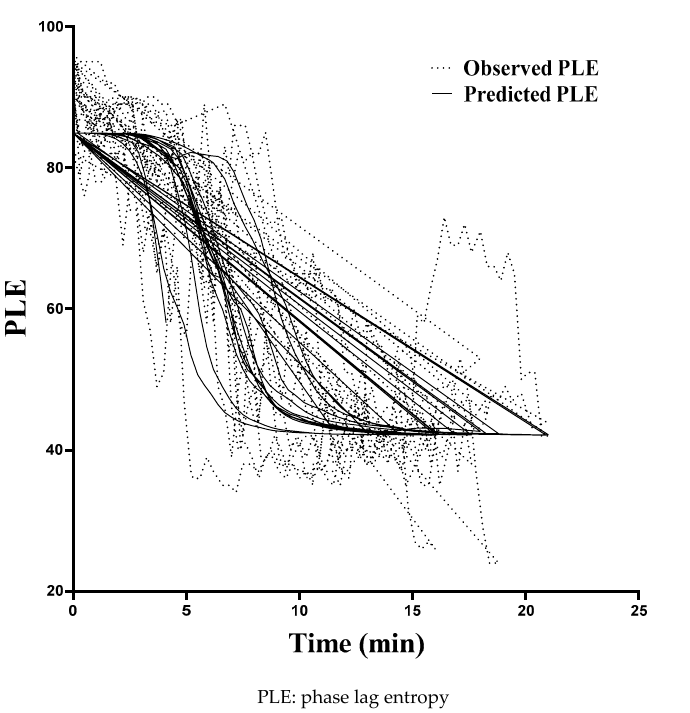
Figure 3. The phase lag entropy-time relationship for each participant as described by the model of pharmacodynamic. The area under the curve and receiver operating characteristic curve of phase lag entropy, showing the ability of the depth of anesthesia monitor to discriminate between modified observer’s assessment alertness/sedation scale ≤ 2 and modified observer’s as- sessment alertness/sedation scale score > 2, are presented in Figure 4. A phase lag entropy ≥ 75 identified modified observer’s assessment alertness/sedation scale score ≤ 2 with a sensitivity of 86.2% and a specificity of 95.0%, indicating that phase lag entropy ade- quately reflects hypnotic depth.